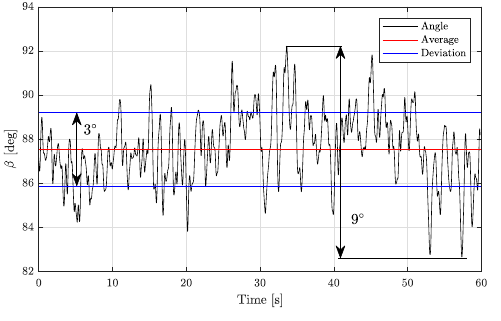
Figure 6. Time history of angle β indicated in Fig. 4 b).